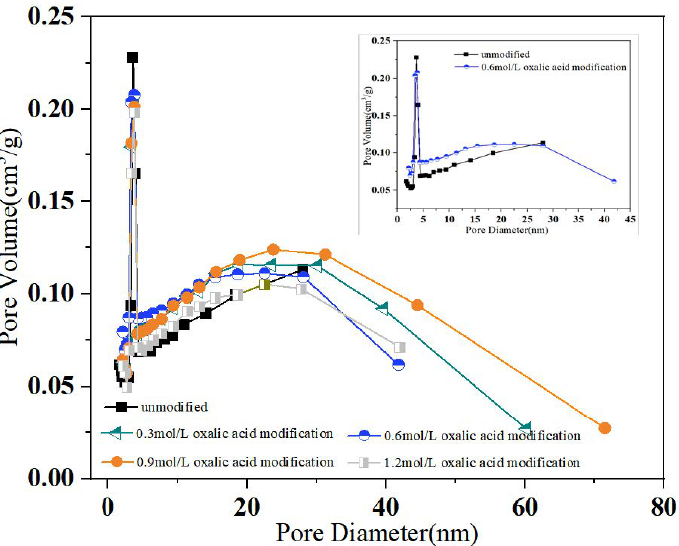
Figure 3. Pore size distributions of oxalic acid-modified activated carbons with different concentra- tions using the BJH method.